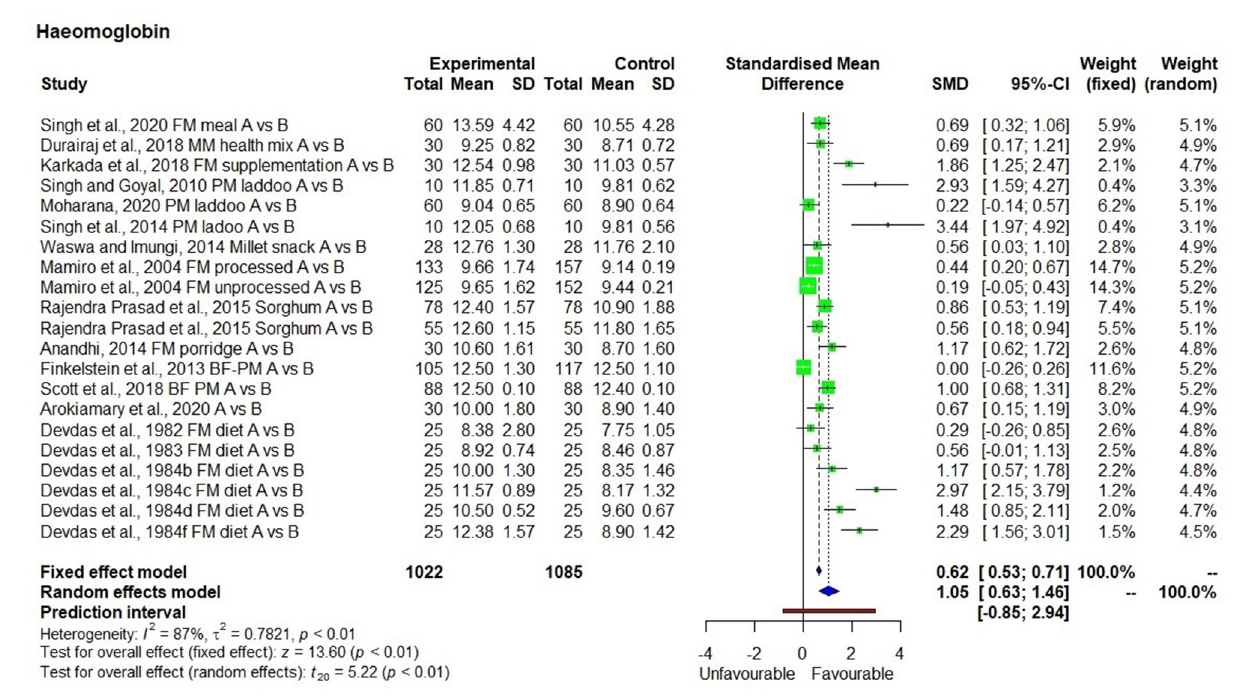
FIGURE 2 | Effect of consuming millets on Hemoglobin